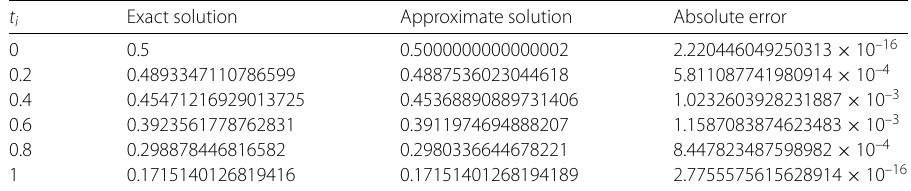
Table 6 The absolute errors of approximating y 2, α for (1,2)-system at various t and α =